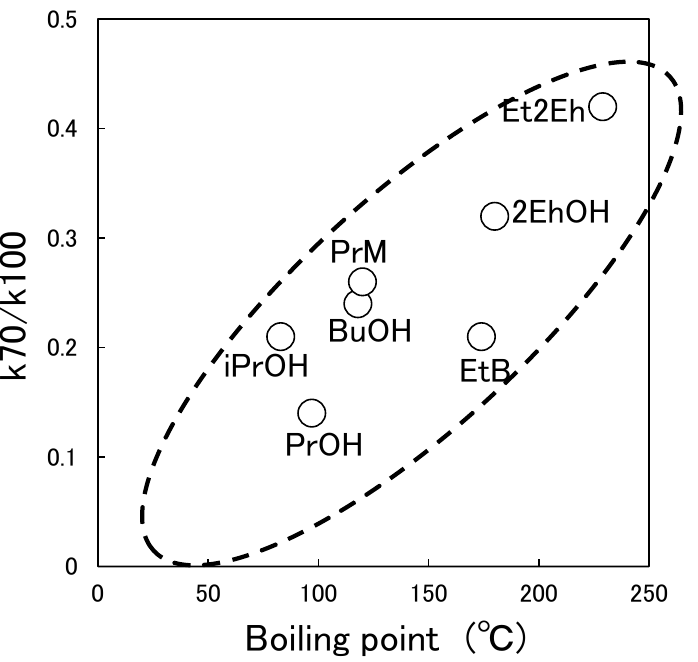
Figure 9. Relationship between boiling point of the additional solvent and k70/k100 values. Figure 10 shows the increasing viscosity percentage levels of the paints containing each organic solvent. The percentages vary remarkably depending on the type of organic solvent. Here, the relationship between the characteristic values of the organic solvent and the increasing viscosity percentage levels is explained.